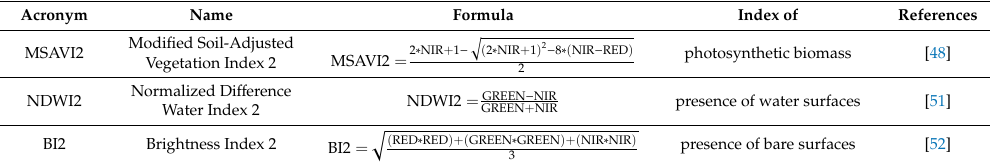
Table 1. Spectral indices selected for analyzing the temporal diversity, serving as proxies of seasonality in vegetation biomass, presence of water surfaces, and bare